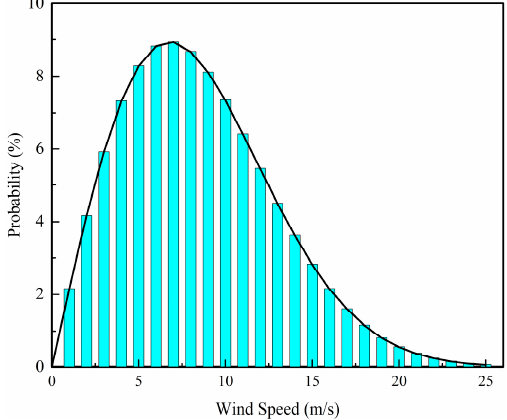
Figure 4. Weibull probability distribution of wind speed.